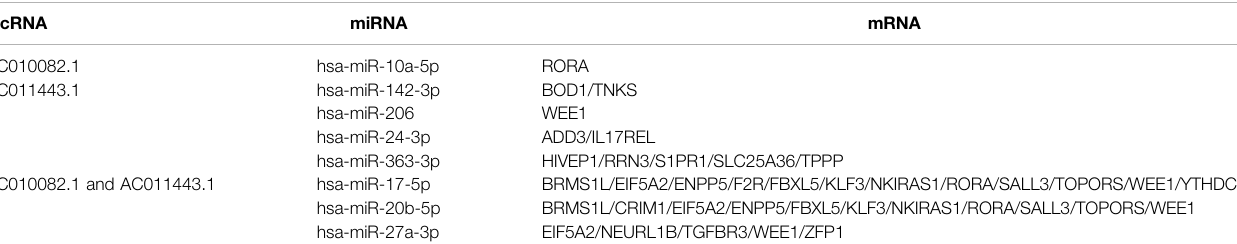
TABLE 1 | AC010082.1- and AC011443.1-related target miRNA and target mRNA.